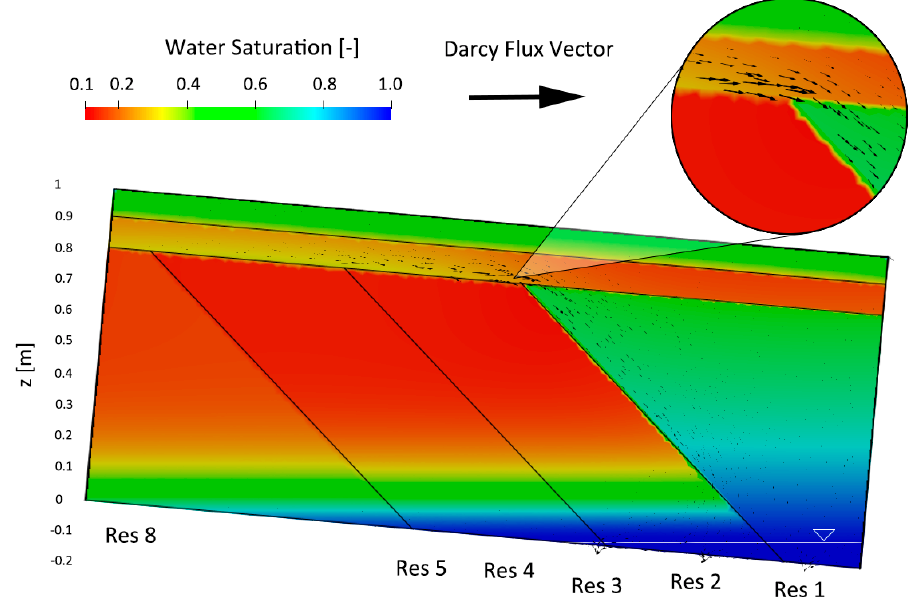
Figure 6. Simulated results of the flow model with a reduced infiltration rate and lowered water table (z ≈ − 13 cm). Simulation results show that the infiltration is diverted through the FCL towards the anorthosite material and that secondary capillary barrier effects (CBEs) between the anorthosite and HI material persist, similar to conditions in the laboratory experiment for higher infiltration rates. Darcy flux vectors are scaled the same as those shown in Figure 4, which are smaller in this case